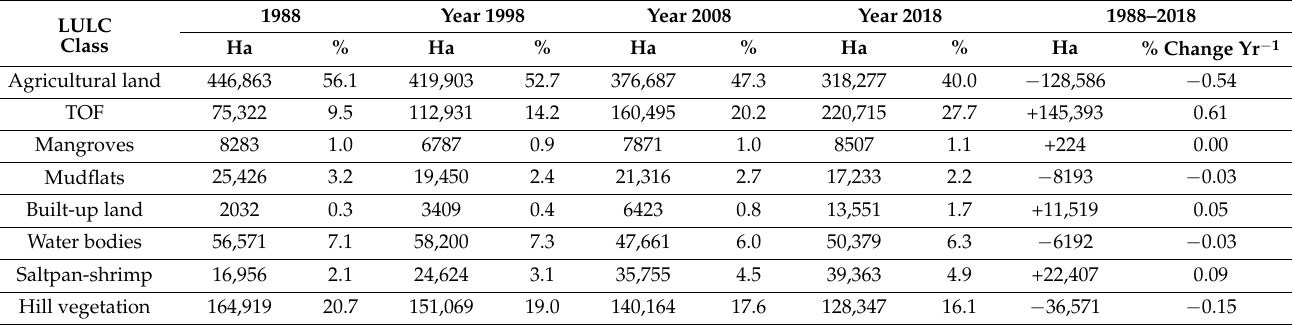
Table 3. Area and annual change of LULC in the eastern